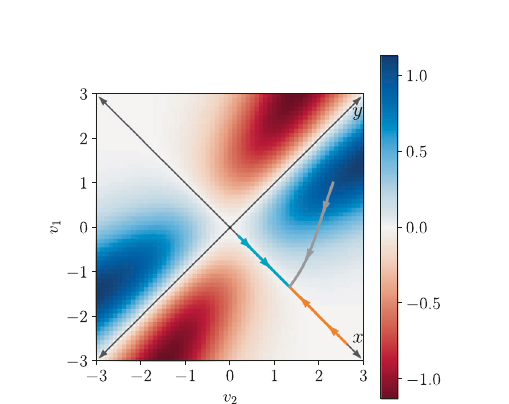
Fig. 5 | Vorticity and deterministic trajectories. Vorticity f ( x ) of the vector fi eld withcomponents ~ σ ρ ð x Þ (cid:3) log ð ~ ω ρ ð x Þ = ~ ω (cid:2) ρ ð x ÞÞ , ρ =1,2,fortheCMOSmemorymodel ( V dd =1.4and v e =0.1,asinFig.1).Theorange,cyanandgreylinescorrespondtothe same deterministic trajectories of deterministic trajectories of Fig. 1.